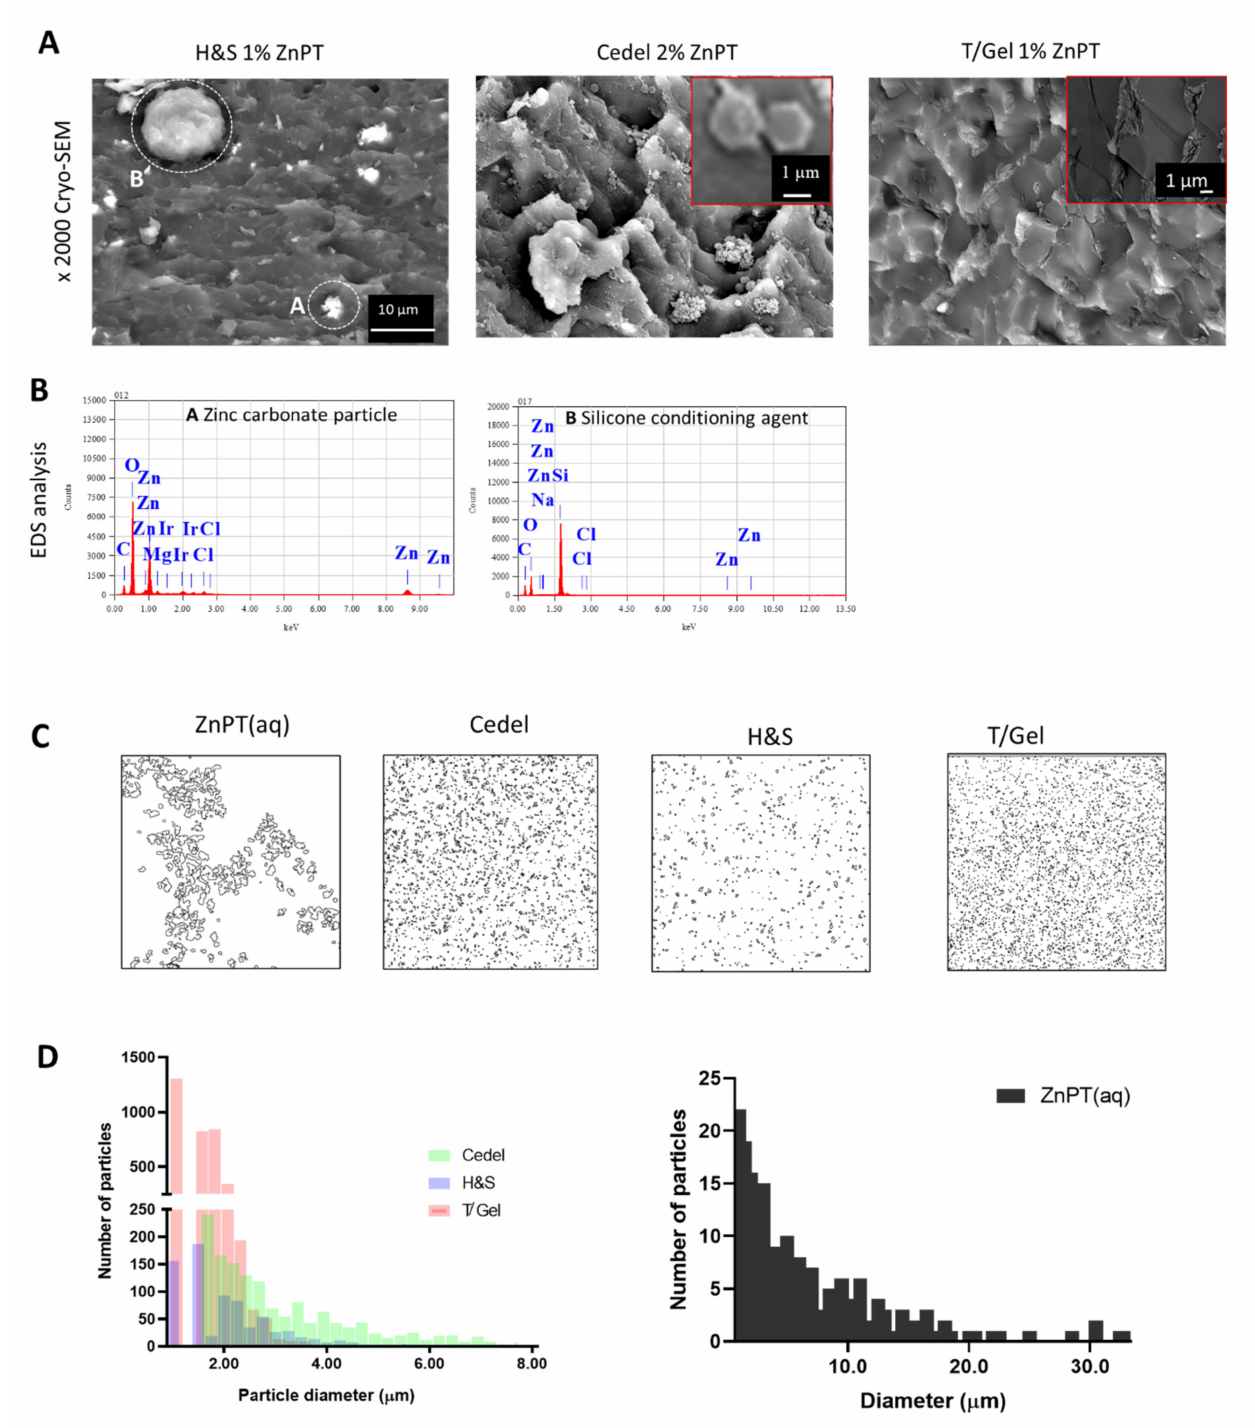
Figure 2. Microstructure and particle size analysis of commercial formulations . ( A ) Cryo-SEM images with ( B ) accompanying EDS for Head and Shoulders. Note the different morphologies of the ZnPT particles. In H&S, particles have a platelet shape; for Cedel, more particle agglomer- ation is evident. T/Gel uses fine particle size ZnPT that is difficult to observe, even at × 10,000. ( C ) Particle outline images used for size analysis, presented in ( D ) showing Ferets diameter for various